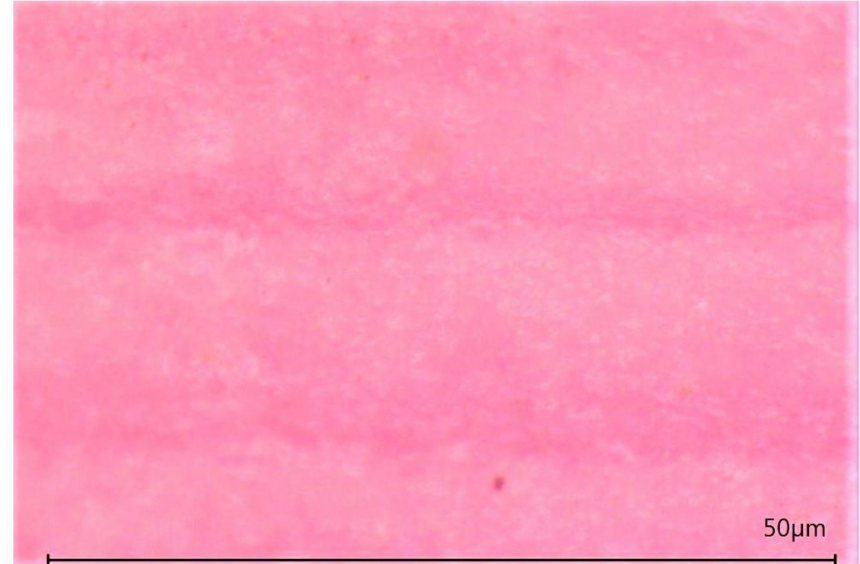
Figure 11. Cross-sectional area of a group C sample. Ink layers appear as thin dark lines between brighter resin layers. The specimen was colored prior to microscope imaging.